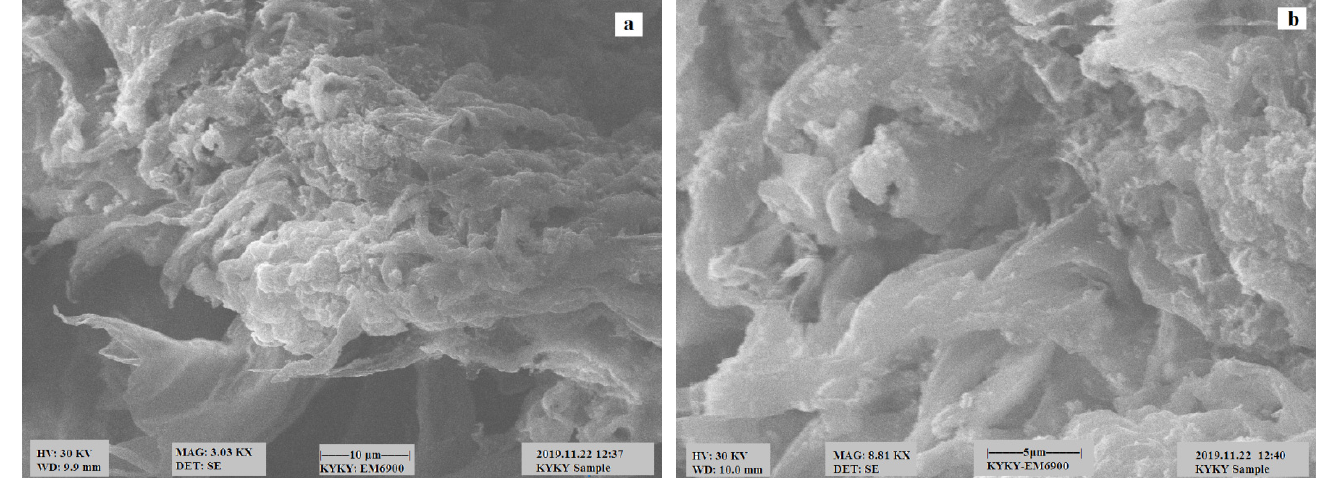
Figure 2. SEM images of the CeO 2 /corncob nanocomposite under magnification of 3.03K× ( a ) and 8.81K× ( b ).